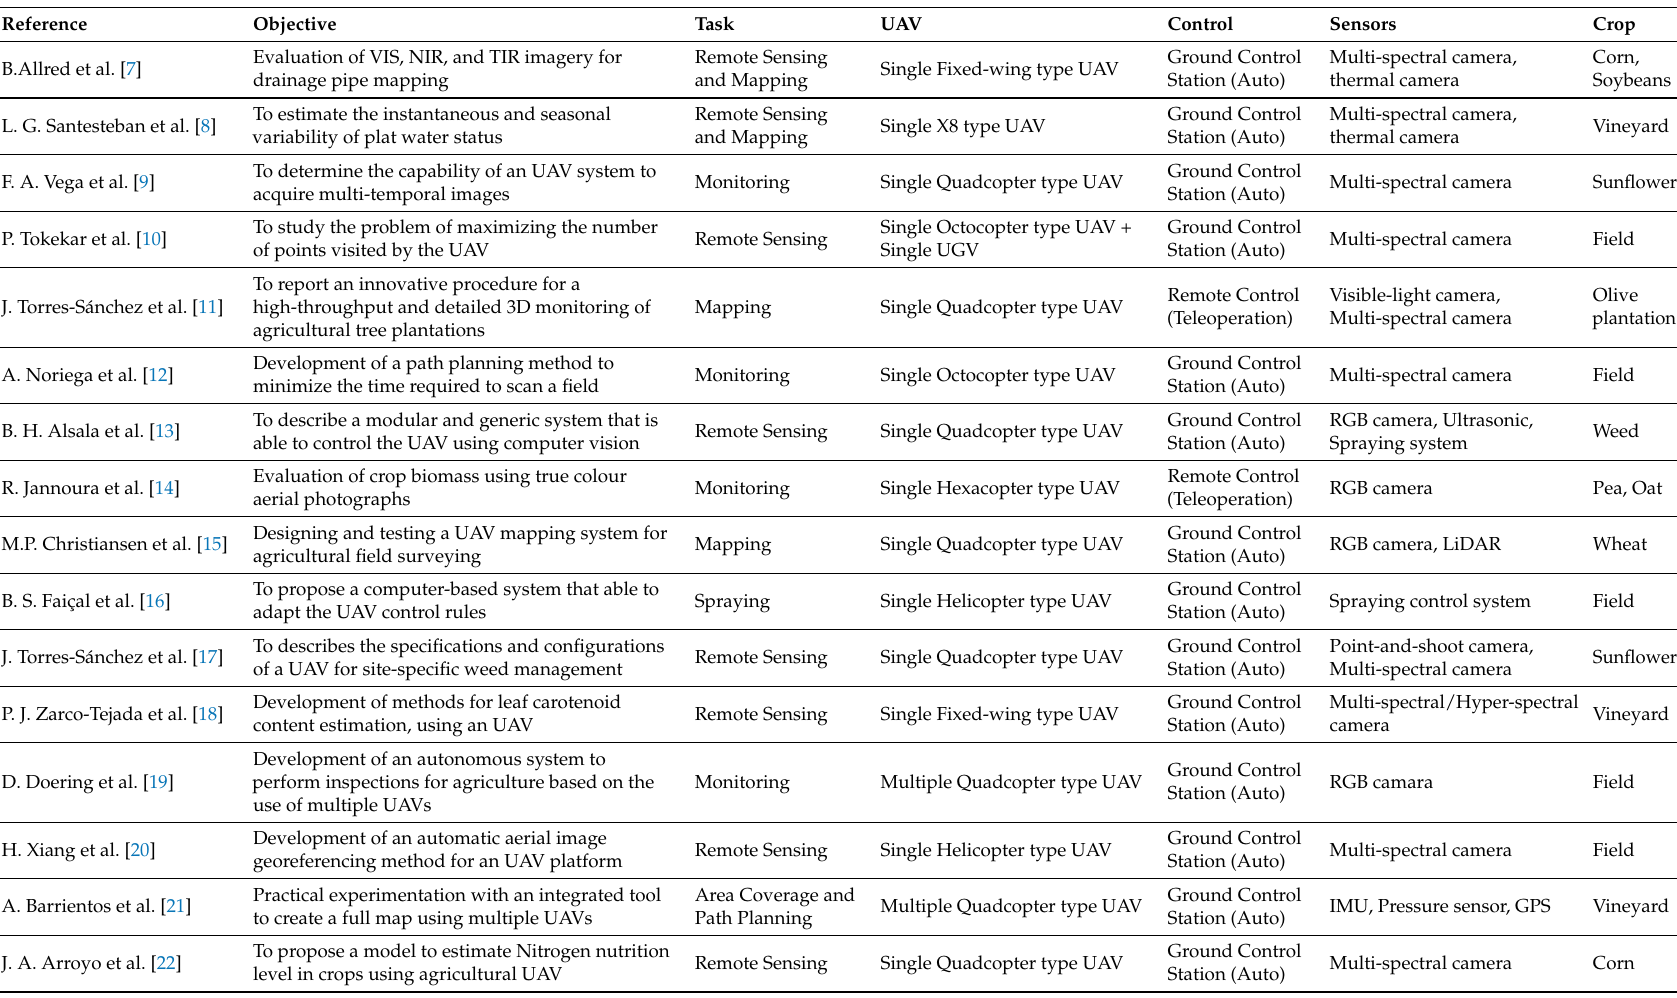
Table 1. Datasheet explaining reference, objective, agricultural task, UAV type, control method, sensors, and target crop for a recent study using an agricultural UAV.